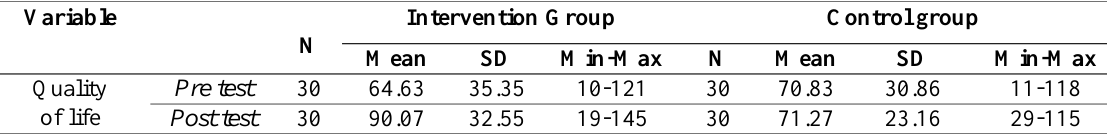
Table 3: Differences in quality of life of cancer patients in intervention group and control (n=60)